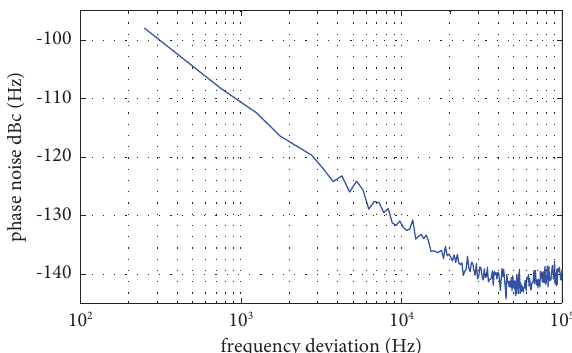
Figure 5: Frequency scanning source single-frequency signal phase noise (output frequency is 10.9GHz).